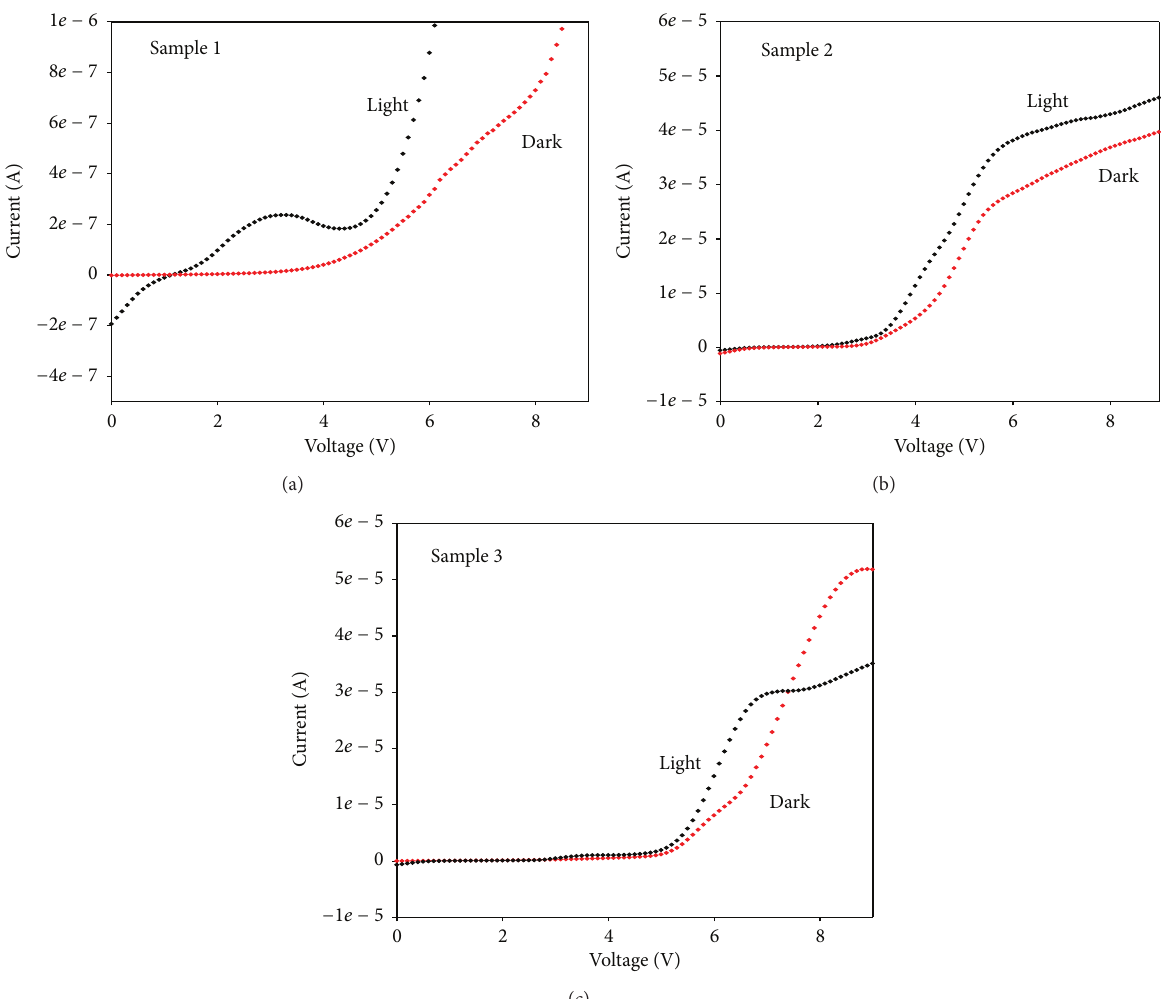
Figure 5: Current-voltage ( 𝐼 - 𝑉 ) characteristics of the PESC of ITO/Cu 2 O/PVC-LiClO 4 /aluminum under dark and light illumination.